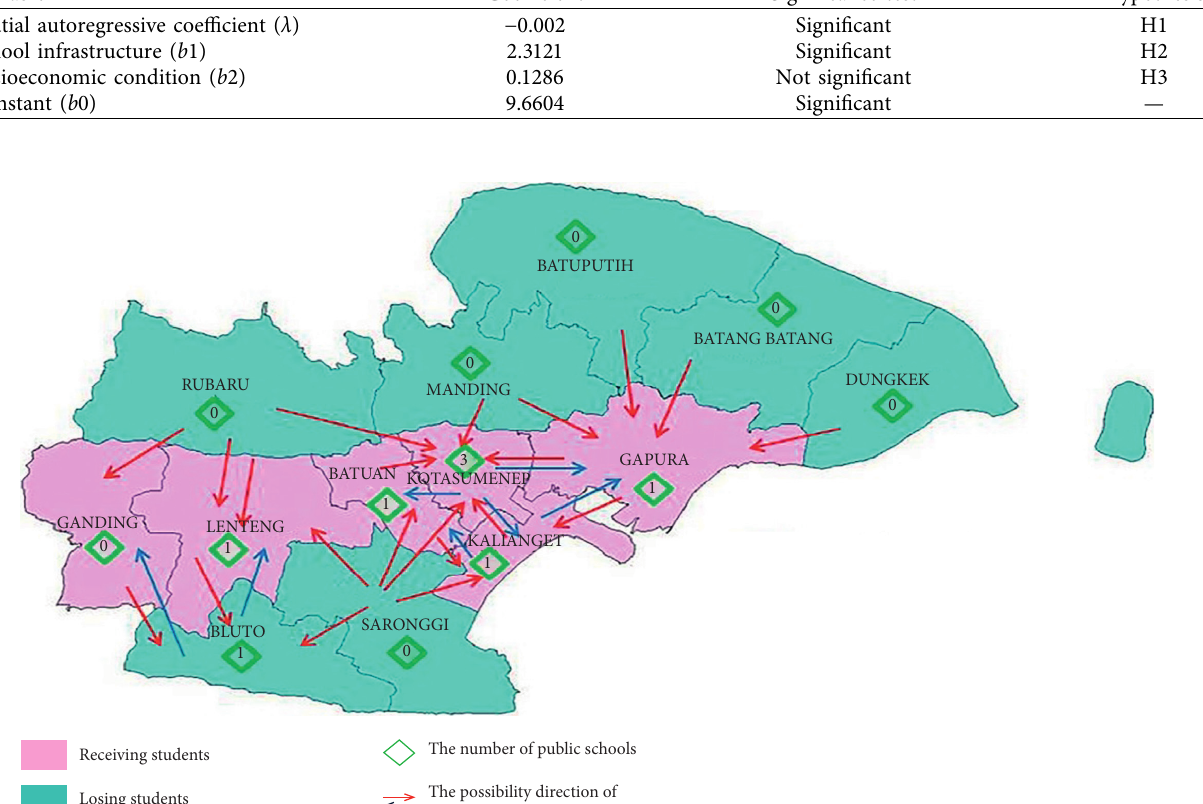
Figure 3: The receiving and losing districts and the directions of the students’ migration.